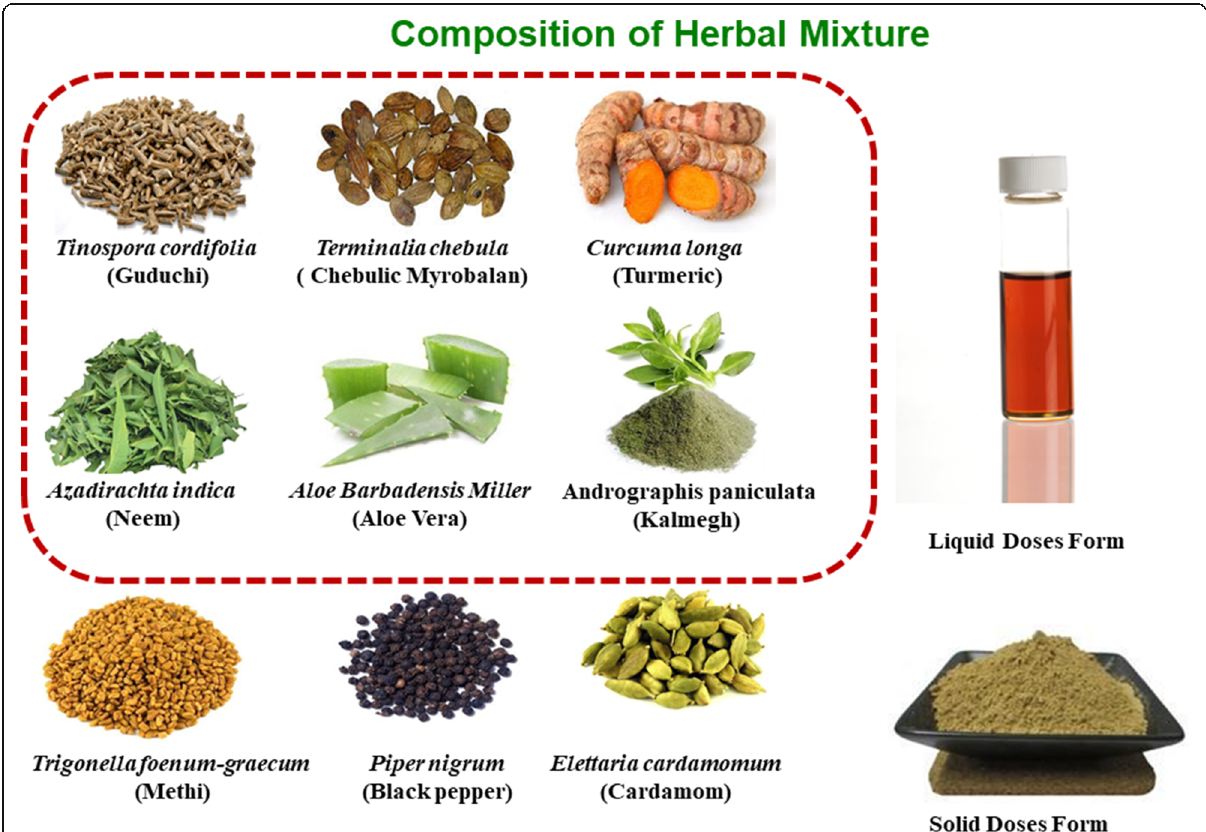
Fig. 6 Composition of multi herbal formulation (ASKK16-LIV01) containing six medicinal herbs and three medicinal